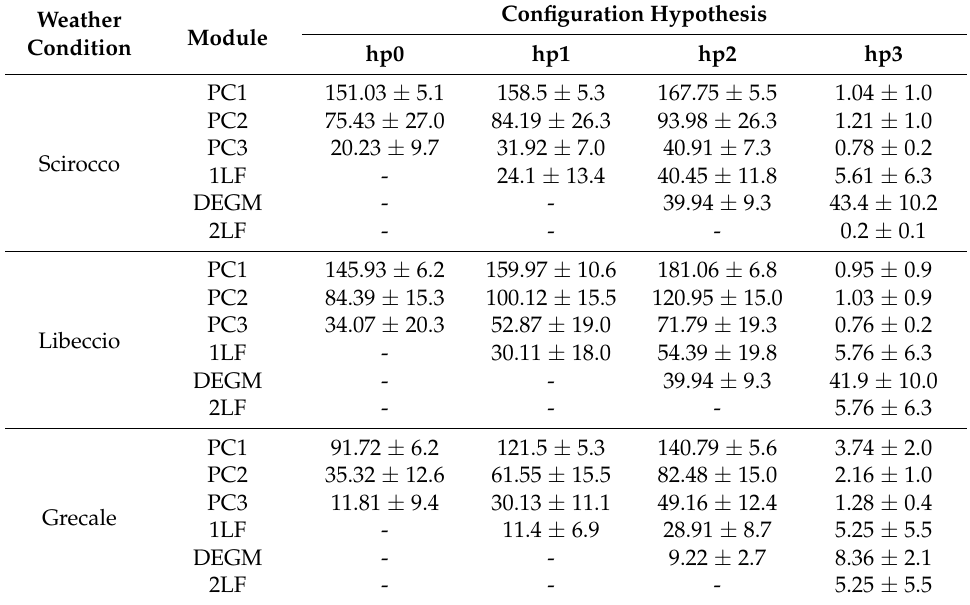
Table 3. Mean and standard deviation of FT (expressed in hours) calculated in all modules of the harbour configurations under different weather